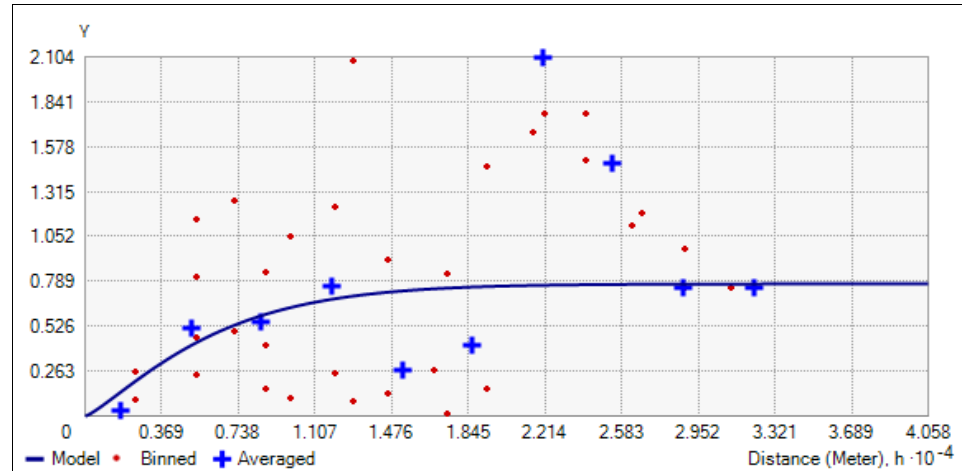
Figure 4. Semivariance model for the groundwater phosphate